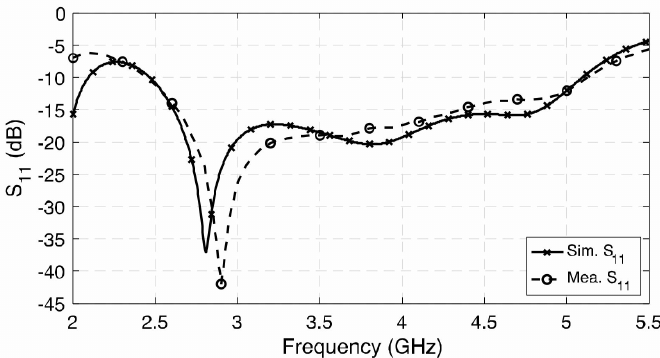
Figure 11. Simulated and measured S 11 of the proposed antenna.